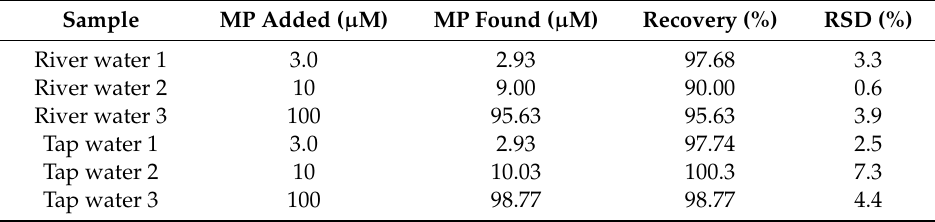
Table 2. Analytical results of MP in real samples using the proposed method ( n = 3).